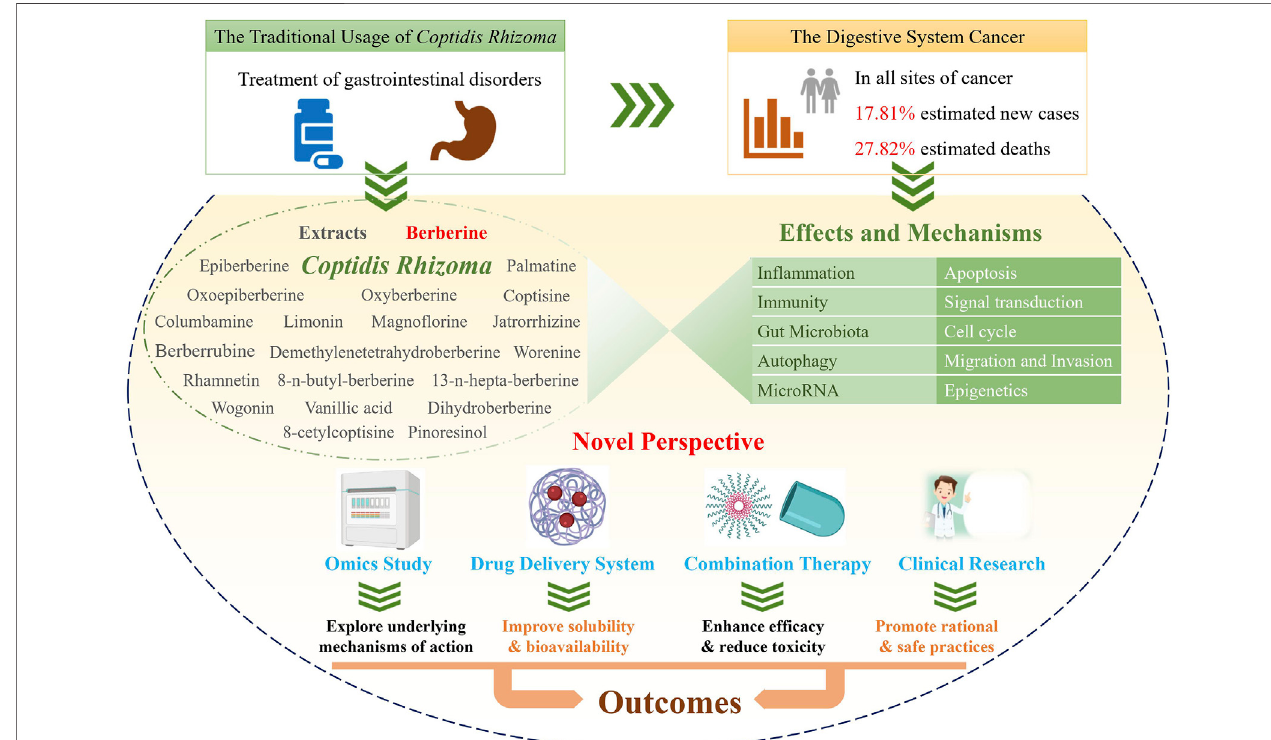
FIGURE 2 | A scheme for current advance in Coptidis Rhizoma for gastrointestinal and other cancers. A brief scheme showing main features of Coptidis Rhizoma and key roles and relationship with cancers.